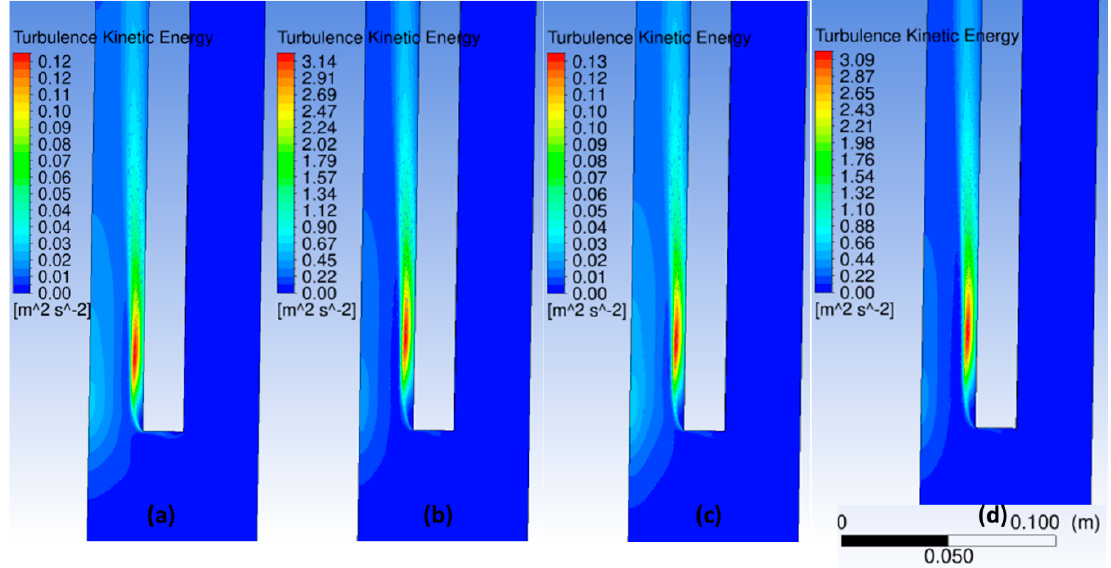
Figure 9. Turbulence Kinetic Energy distribution at the bottom of the internal tubing for a mass flow rate injection with constant water properties of 2 kg/s ( a ) and 10 kg/s ( b ) and with the IAPWS-IF97 properties for 2 kg/s ( c ) and 10 kg/s ( d ).